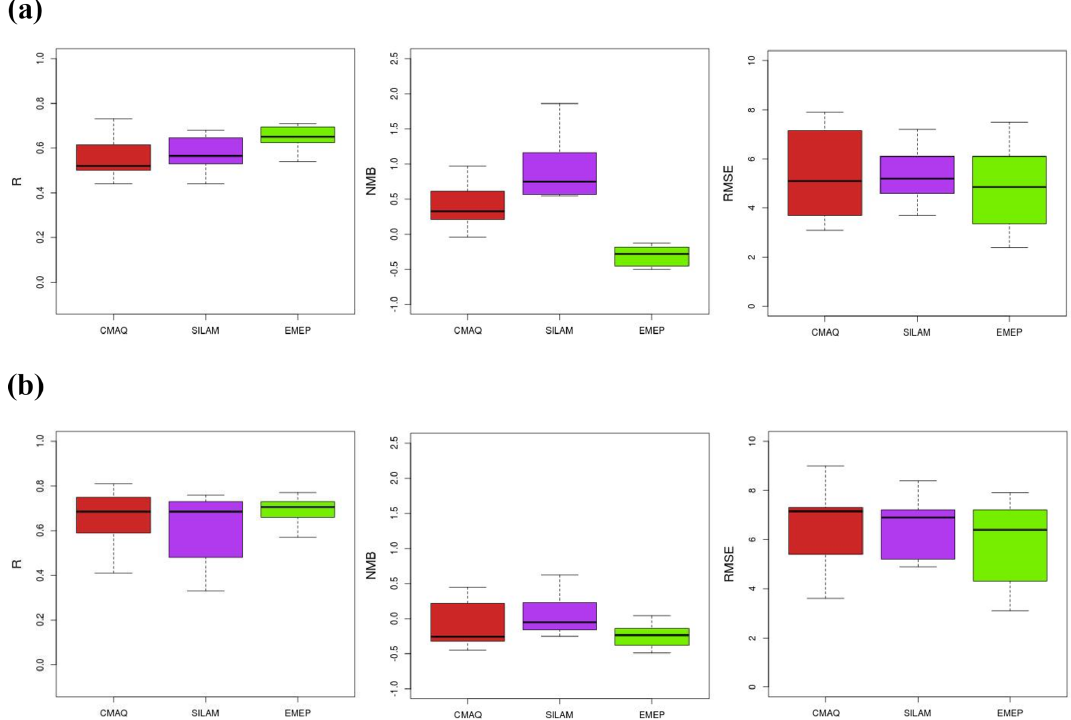
Figure 6. Comparison of statistical indicators for PM 2 . 5 daily means (in the order R , NMB and RMSE) between three CTMs at (a) rural background stations and (b) urban background stations. Outliers shown as small